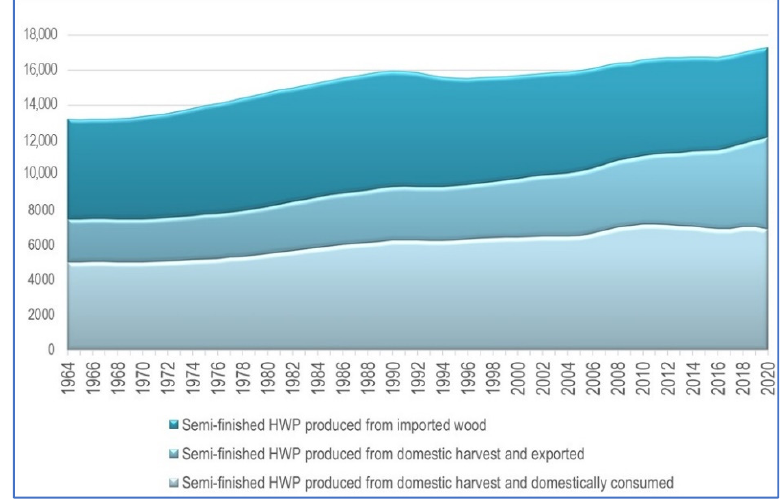
Figure 7. Carbon stock of the HWP pool 1964–2020 (kt C).